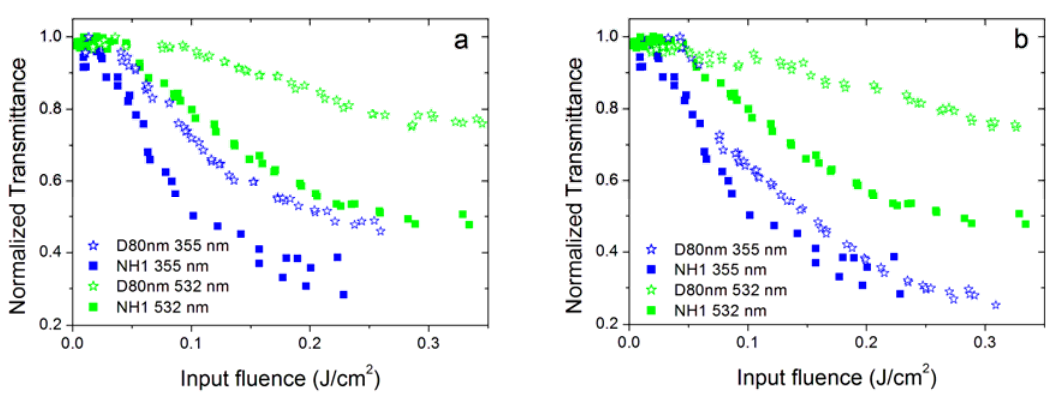
Figure 10. Optical limiting properties of the NH1sample (dahlia—60 nm) and D80nm (dahlia—80 nm) at 355 and 532 nm wavelengths: ( a ) for nanoparticle concentrations of 0.025 and 0.0125 g / L, respectively, and ( b ) for the same concentration of 0.025 g / L for both samples.